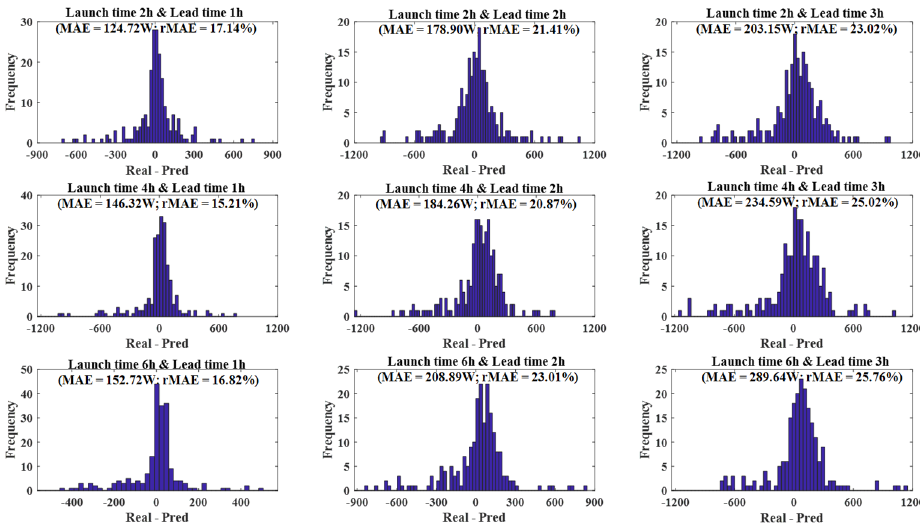
Figure 10. Error distribution for different subsets. A Laplacian distribution is assumed to create prediction intervals in terms of the MAE.